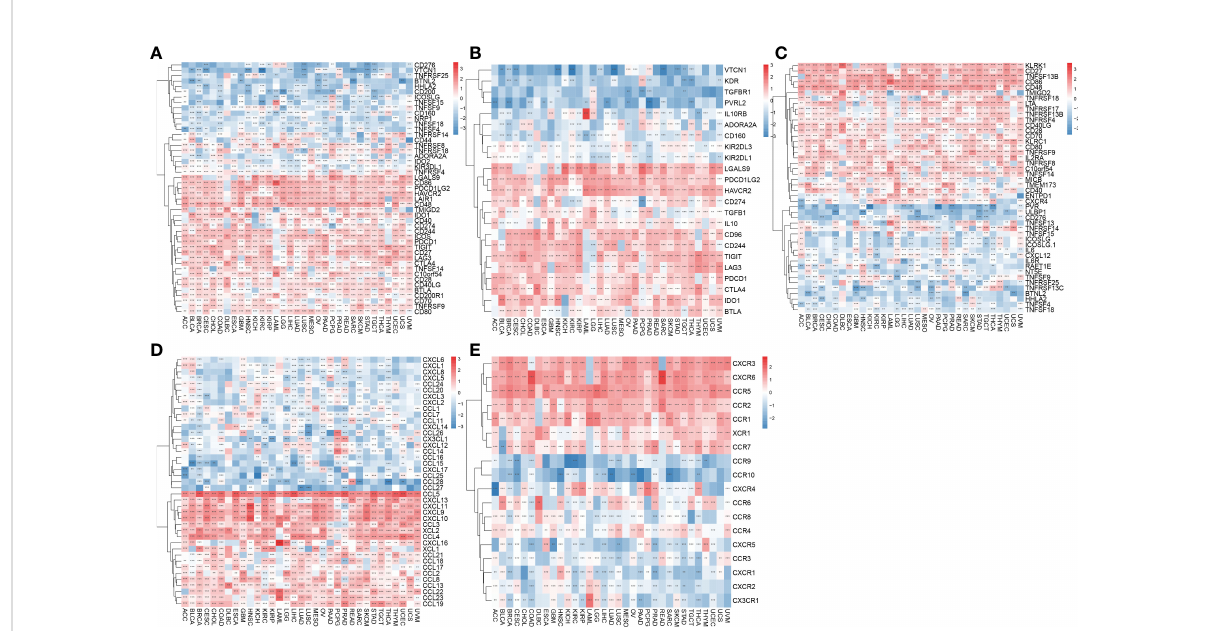
FIGURE 11 Association of AIM2 in fl ammasomes scores with immune-related genes. (A) Relevance between AIM2 in fl ammasomes scores and immune checkpoint in human tumors (Spearman ’ s correlation test). (B) Correlation between AIM2 in fl ammasomes scores and immunosuppressive genes in human tumors (Spearman ’ s correlation test). (C) Correlation between AIM2 in fl ammasomes scores and immune activation genes in human tumors (Spearman ’ s correlation test). (D) Correlation between AIM2 in fl ammasomes scores and chemokines in human tumors (Spearman ’ s correlation test). (E) Correlation between AIM2 in fl ammasomes scores and chemokine receptors in human tumors (Spearman ’ s correlation test). **p < 0.01, and ***p <